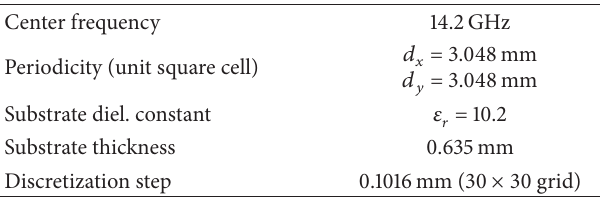
Table 1: Fixed parameters of the periodic structure.